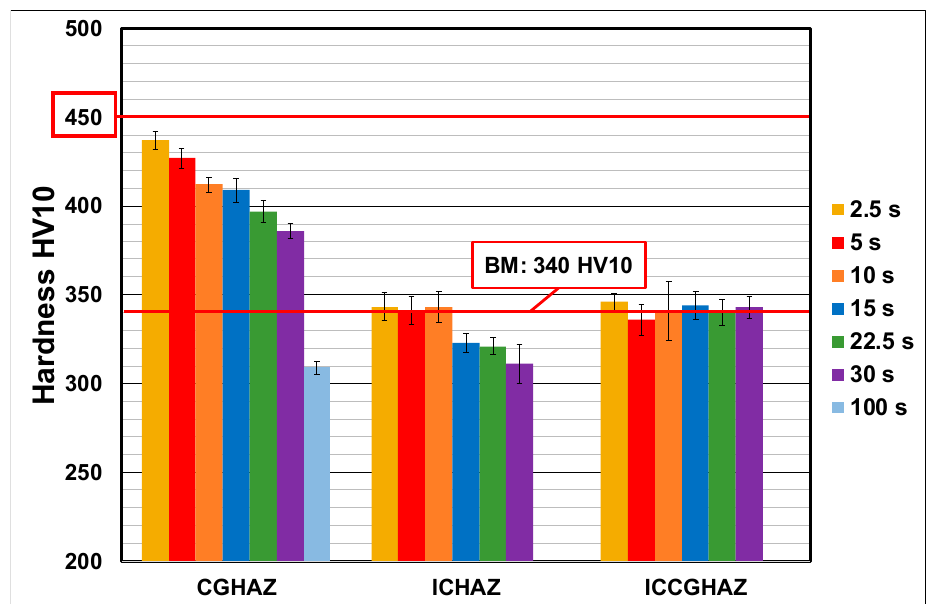
Figure 8. Macro hardness test results in HAZ subzones.